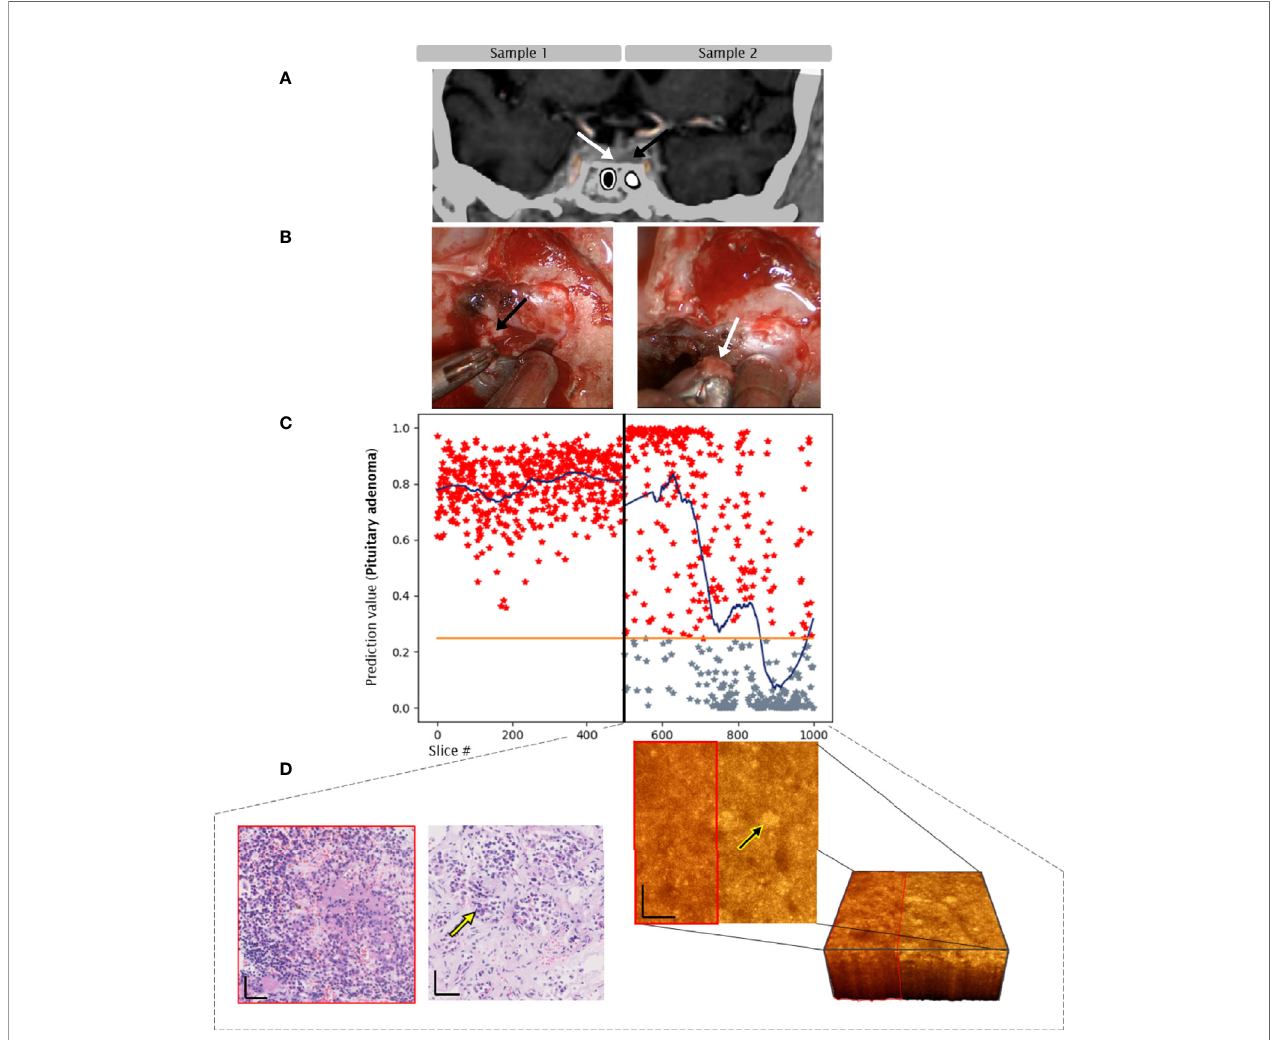
FIGURE 3 | Case 2. Convolutional neuronal network assessment of OCT images of samples of pituitary adenoma (black arrow) and adjacent gland (white arrow). (A) MRI, 9mm microadenoma. (B) intraoperative imaging. (C) Diagram of pituitary adenoma probability. X axis: number of each classi fi ed slice (500 per sample). The orange line indicates the classi fi cation threshold for pituitary adenoma/non-adenoma. The blue curve indicates an average of 150 slices to visualize the network prediction. (D) OCT 3-dimensional visualization of the sub-volume of sample 2 – transition zone, H/E slices of pituitary adenoma (red box) and pituitary gland tissue. Yellow arrows indicate nests. Scale bars: 50